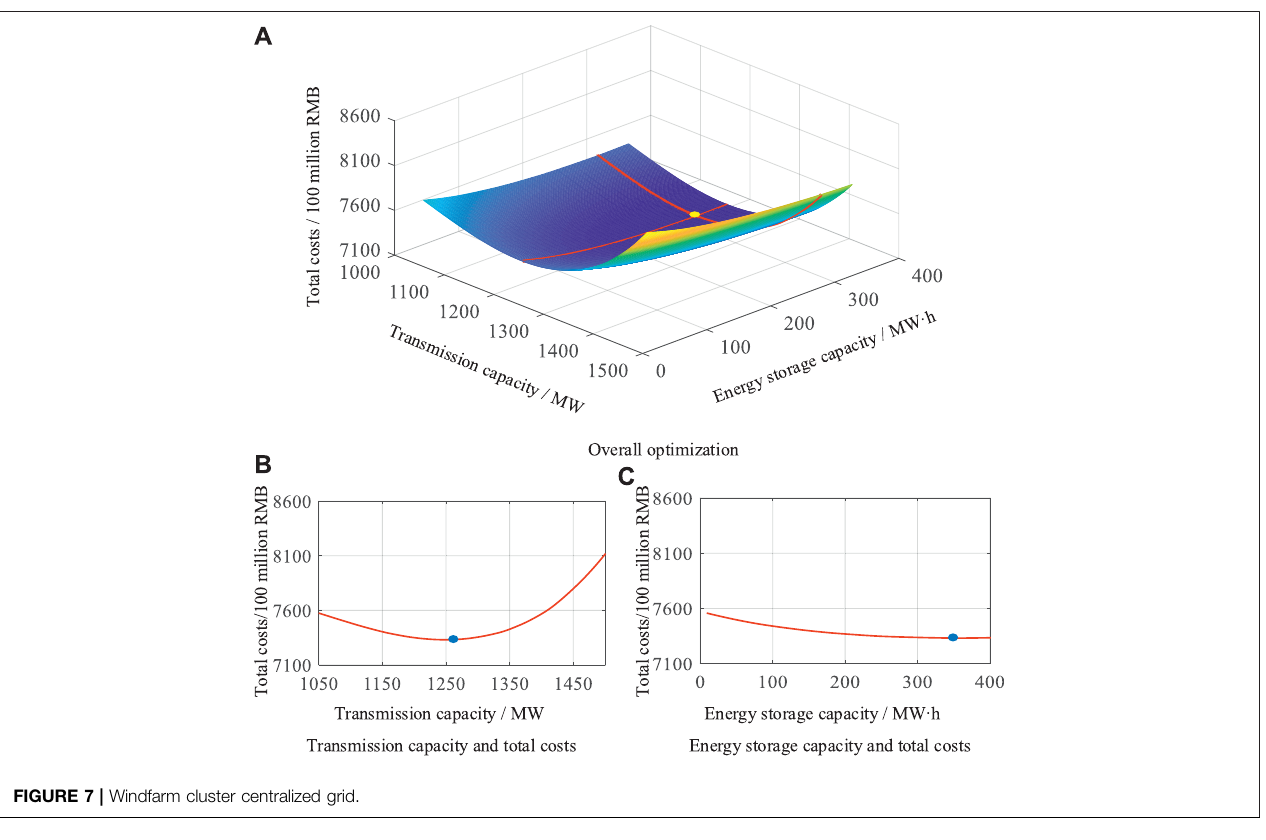
FIGURE 7 | Windfarm cluster centralized grid.